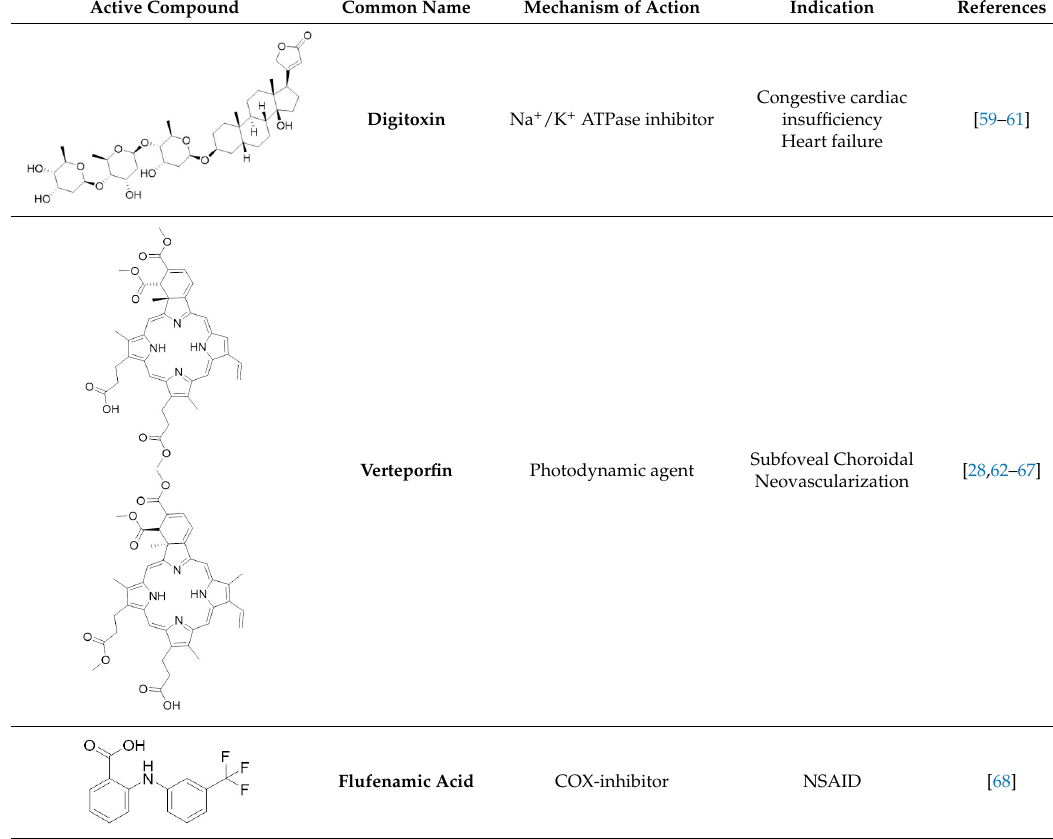
Table 2. Pharmaceutical agents directly modulating YAP-TEAD interaction.